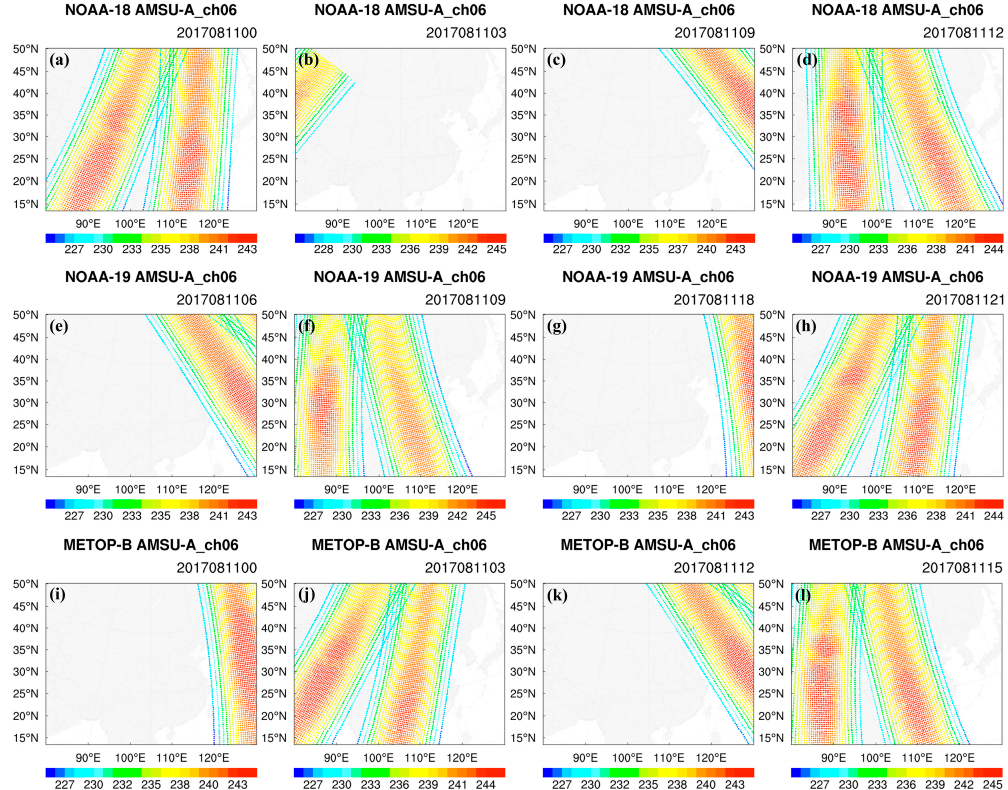
Figure 2. The coverages of AMSU-A channel 6 from satellites NOAA-18 ( a – d ), NOAA-19 ( e – h ), and METOP-B ( i , j , k and l ) used in RMAPS on 11 August 2017, at different times. Different colors denote the brightness temperatures (K) from the satellite radiance observations. Remote Sens. 2019 , 11 , 54